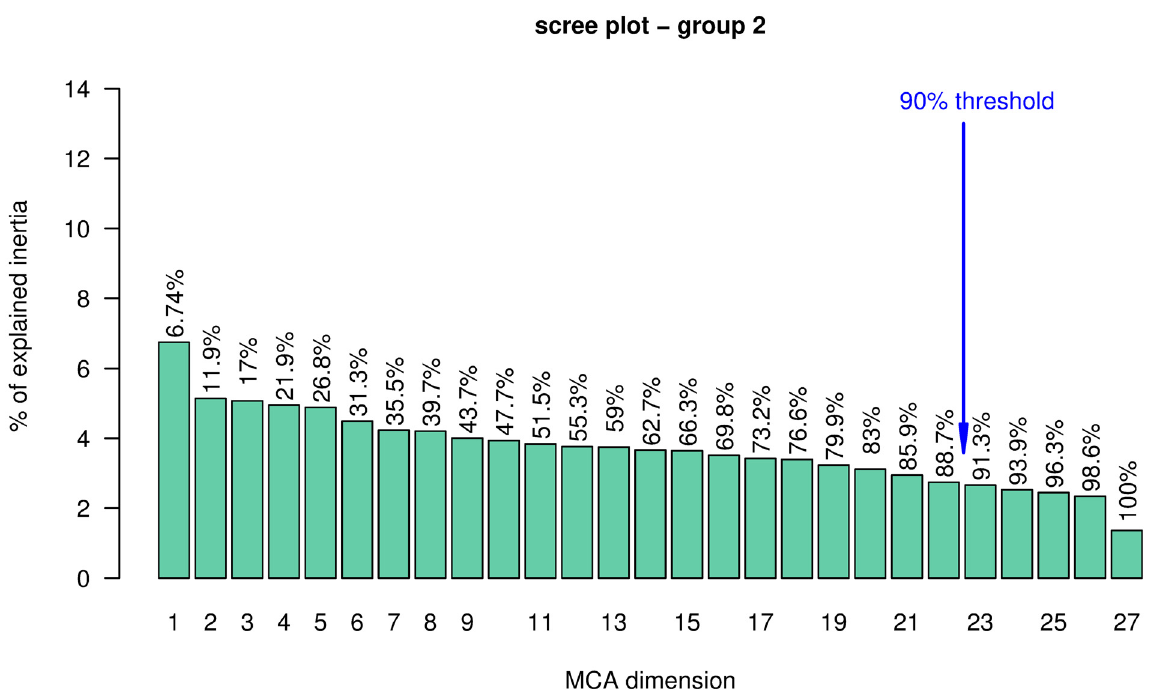
Number of students belonging to each cluster. We only considered clusters with more than 5% of the data for further analysis (in bold).